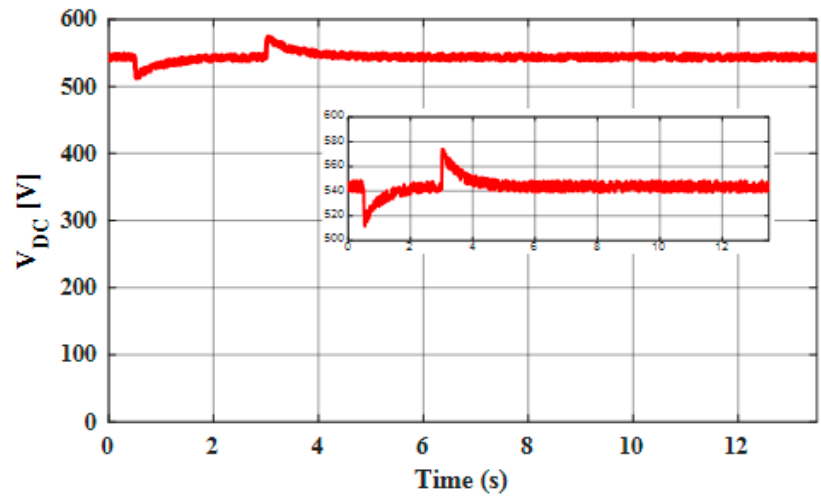
Figure 21. Experimental result for the DC-link voltage.